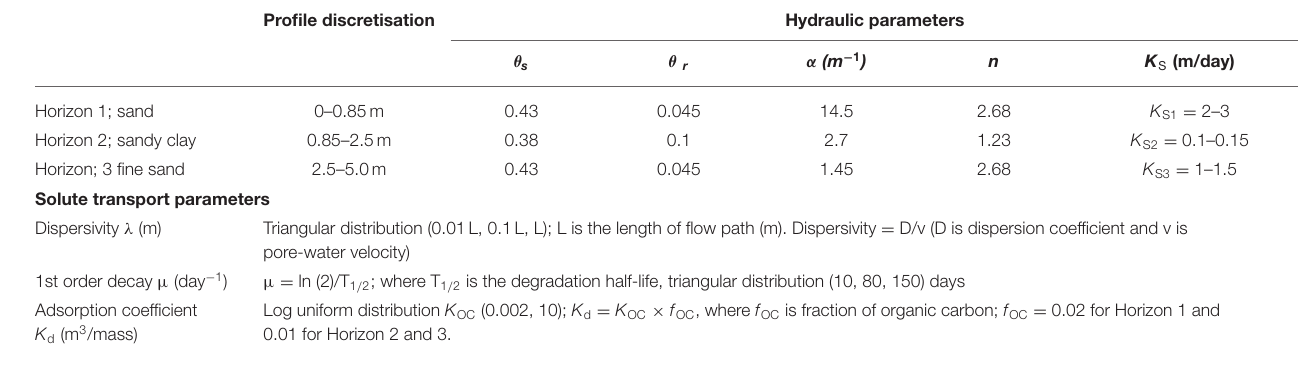
TABLE 1 | Profile layers, hydraulic, and solute transport parameters (m is length units,